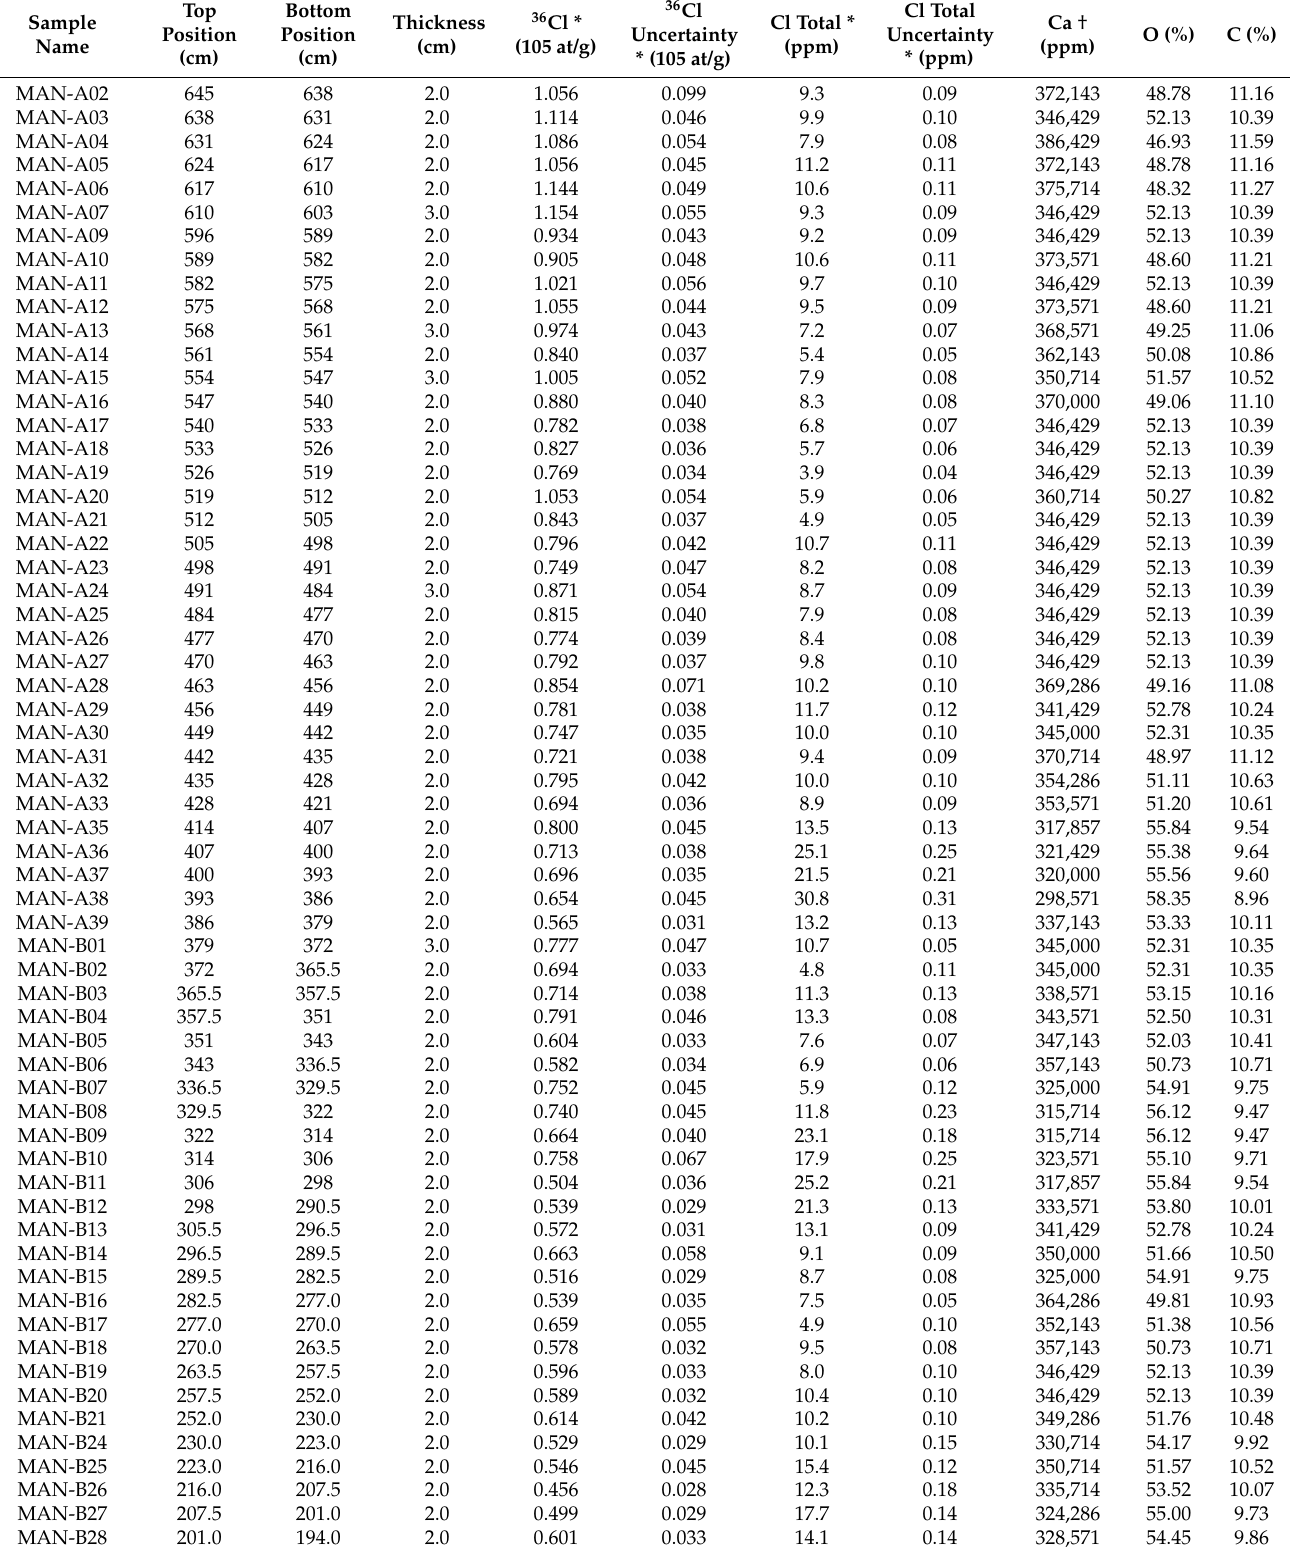
Table 2. Cosmogenic nuclide data of the Manastır Fault